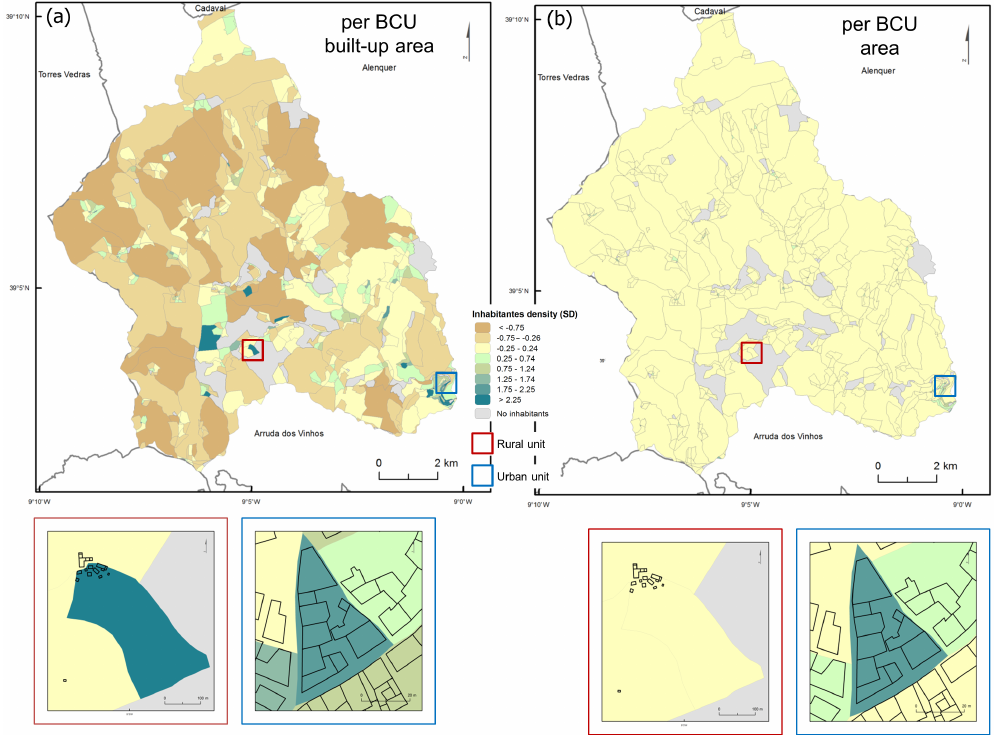
Figure 5. Population density in the Alenquer study area (a) per BCU built-up area, (b) per BCU overall area. To facilitate visualization, the classification of target zones in map (a) was extended to the complete BCU.